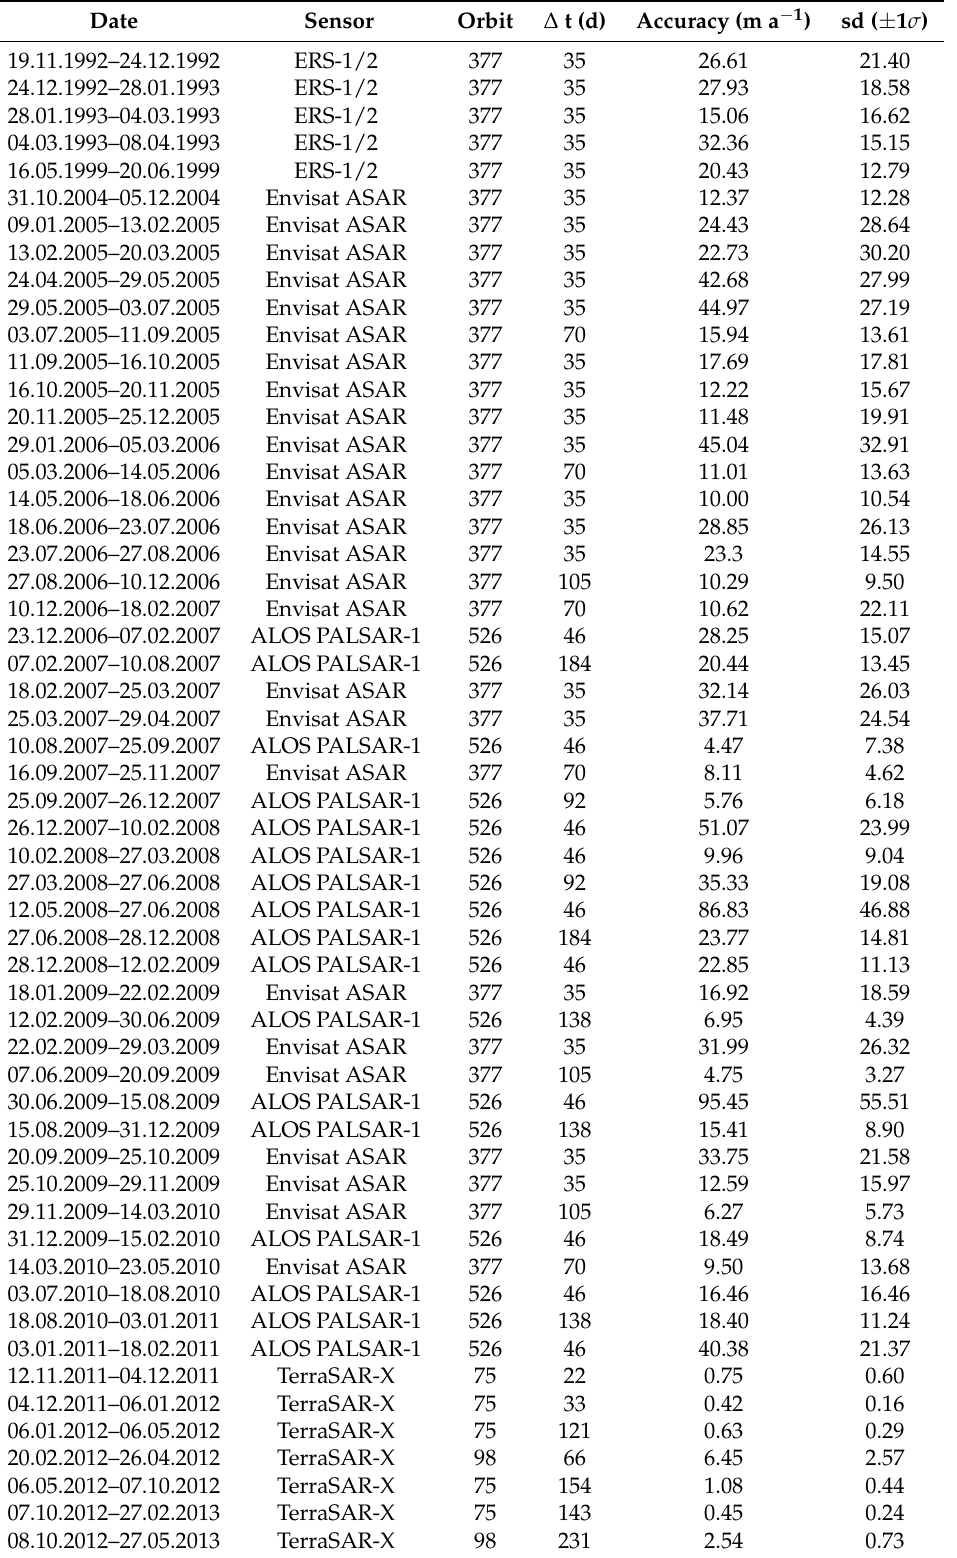
Table A1. Accuracy assessment (m a − 1 ) and the standard deviation (sd) ± 1 σ of the processed surface velocities with ∆ t in days as the time interval in days between repeat SAR acquisitions. As TerraSAR-X and TanDEM-X data are identical in construction, both data sets are categorized as TerraSAR-X. The table is continued on the following